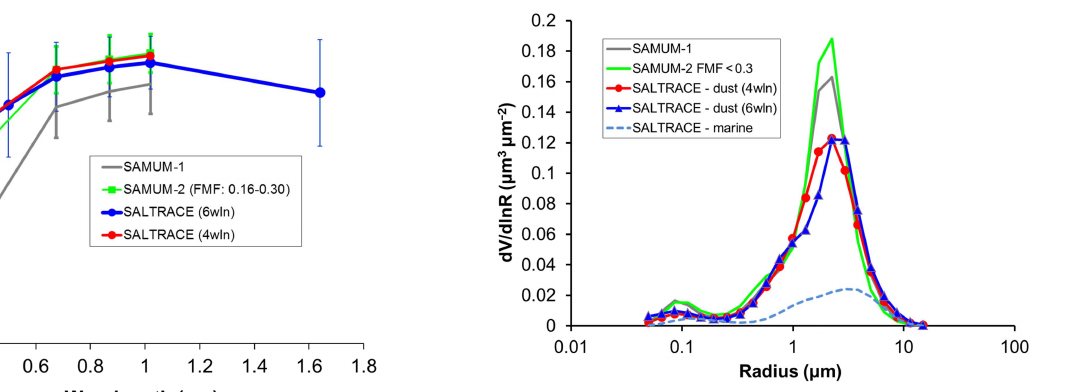
Figure 5. Volume particle size distributions (d V/ dln R ) for SALTRACE as well as the SAMUM campaigns. Average values for dust cases in each campaign are provided, based on the inversion of Cimel sun photometer data. For SAMUM-2, only cases with low fine-mode fractions (FMF) between 0.16 and 0.30 are